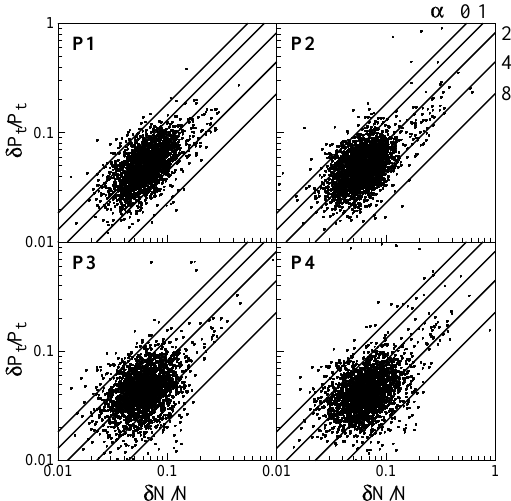
Figure 77: Scatter plots of the relative amplitudes of total pressure vs. density fluctuations for polar wind samples P1 to P4. Straight lines indicate the Tu and Marsch (1994) model predictions for different values of 𝛼 , the relative PBS/W contribution to density fluctuations. Image reproduced by permission from Bavassano et al. (2004), copyright